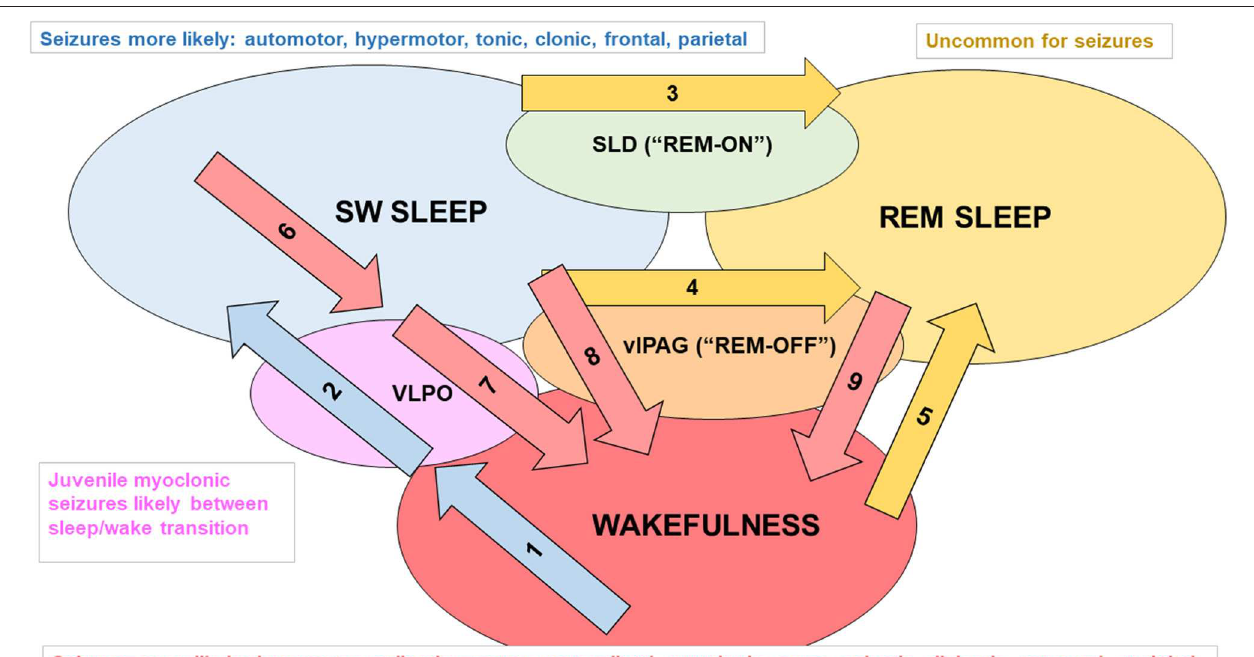
FIGURE 1 | Examples of factors that promote changes in sleep/wake state and seizure types associated with each sleep/wake state. Mammals have two main cycles: the 24h sleep/wake cycle and multiple 90min slow wave sleep (SWS, i.e., NREM)/REM sleep cycles that typically occur within a 6 to 8h period of sleep/inactivity. The sleep/wake state of an individual is influenced by various levels of endogenous clock products (that oscillate in a circadian rhythm) as well as external stimuli (zeitgebers) and allostatic factors (relate to the regulation and maintenance of sleep homeostasis) that act on the suprachiasmatic nucleus (SCN). Daylight is an example of a zeitgeber. It acts on melanopsin-containing retinal ganglion cells that transmit signals indicating the levels of environmental light (and thus the likely time of day) through the retinohypothalamic pathway to neurons of the SCN ( 49). Diminishing daylight reduces the inhibitory signaling of SCN projections to the pineal gland, enabling melatonin secretion. The SCN also regulates sustained sleep/wake states, as lesions of the SCN in rodents disrupt circadian rhythms and lead to random short bursts of sleep and wakefulness (50). Influences on flux in the direction of SWS : Arrow 1: adenosine accumulating from daytime glycogen use, increased release of melatonin in the evening and beyond; Arrow 2: adenosine activating ventrolateral preoptic area (VLPO) “sleep” neurons (foot on SWS gas pedal) (51–53), decreased activity of orexinergic neurons, and allostatic factors (e.g., leptin release after large dinner) promoting VLPO firing. Influences on flux in the direction of REM sleep : Arrow 3: glutamate activating the “REM-ON” neurons of the sublaterodorsal nucleus (SLD, foot on REM gas pedal) ( 54); Arrow 4: decreased excitatory input to REM-OFF neurons of the ventrolateral periaqueductal gray matter (vlPAG, foot off REM brakes); Arrow 5: orexinergic dysfunction (e.g., narcolepsy). Influences on flux in the direction of wakefulness : Arrow 6: adenosine levels diminishing from glycogen regeneration, decreasing melatonin secretion; Arrow 7: VLPO receiving inhibitory input from “wakefulness neurons” including orexinergic neurons in the lateral hypothalamus, noradrenergic (NE) neurons in the locus coeruleus, serotonergic (5HT) neurons in the raphe nuclei, histaminergic neurons of the tuberomammillary nucleus, and cholinergic neurons of the pons, basal forebrain, and medial septum (foot off wake brake), and a lack of excitatory adenosine (foot off SWS gas pedal); arrow 8: diminished firing of NE and 5HT at vlPAG (foot off wake brake); arrow